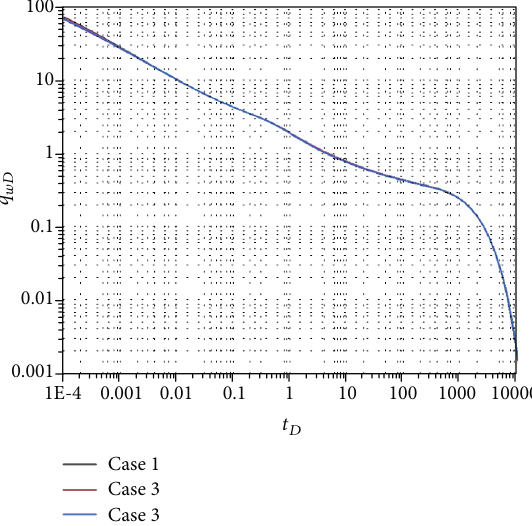
Figure 7: In fl uence of di ff erent fracture lengths on production at the constant total fracture